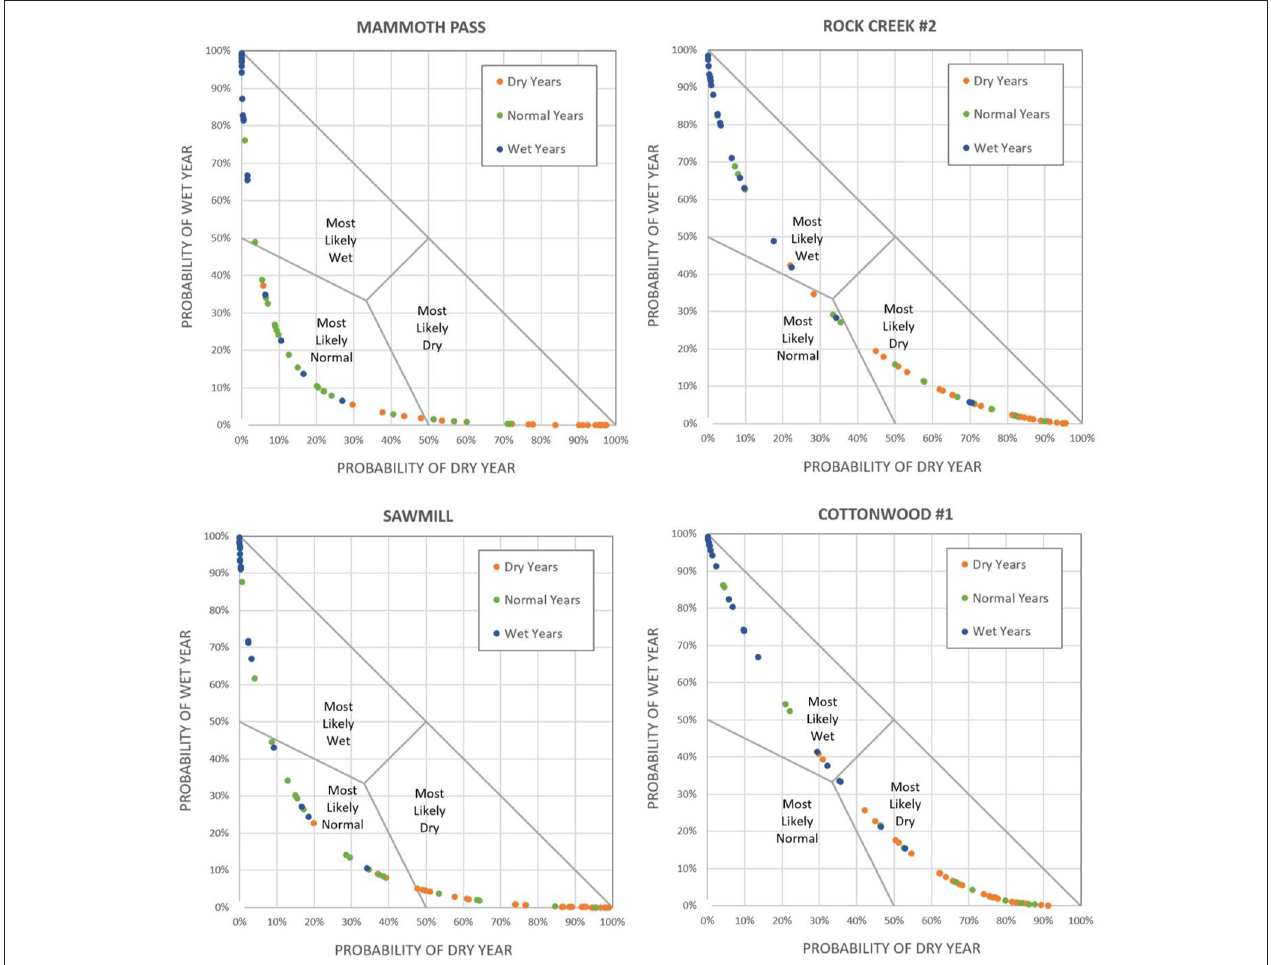
FIGURE 5 | Probability assigned to categories “dry” (x axis) and “wet” (y axis) each year in 1951–2016. The actual observed category each year is indicated in color, according to the legend. The distribution of colors appears consistent with the